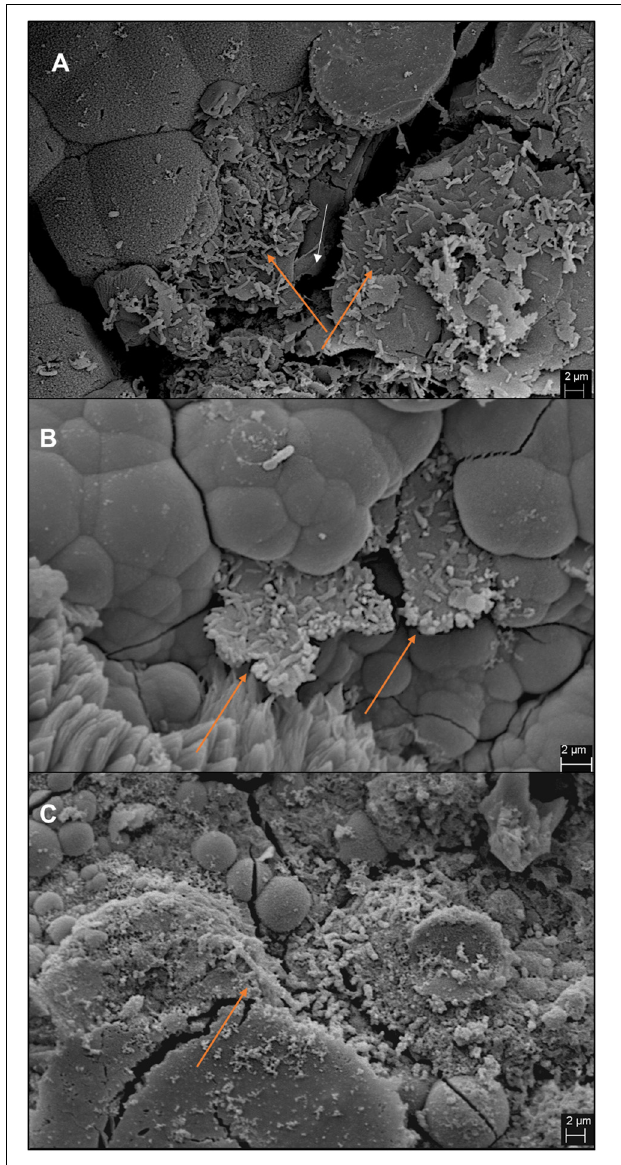
FIGURE 5 | Images of iron coupons extracted from bottom section of the column post-experiment. Coupons from IM1-incubated sand column (A) , IM1-incubated glass column (B) , and IS5-incubated glass column (C) are shown. Cell clusters are indicated by orange arrows and iron surface is indicated by white